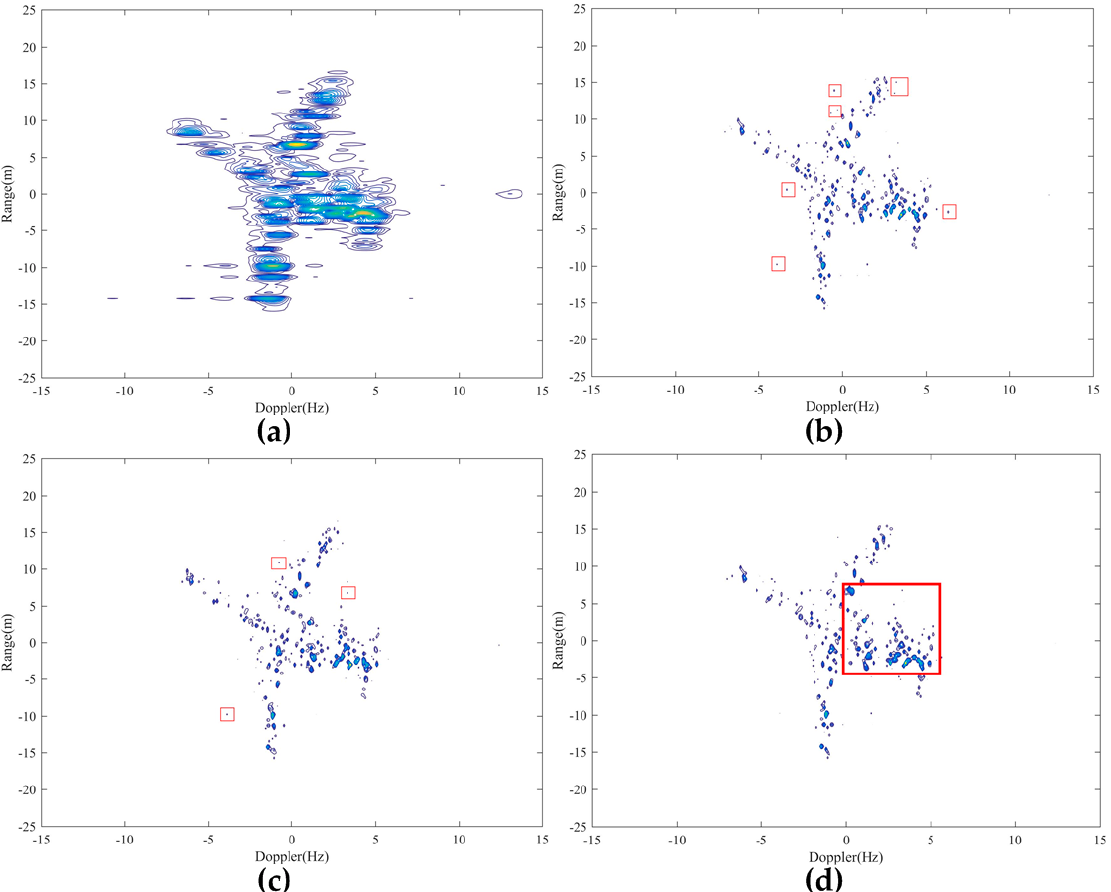
Figure 2. Comparison of ISAR imaging by RD [48], RV-SBM, and the proposed CV-SBM: ( a ) imaging result by RD; ( b ) imaging result by [48]; ( c ) imaging result by RV-SBM; ( d ) imaging result by CV-SBM.